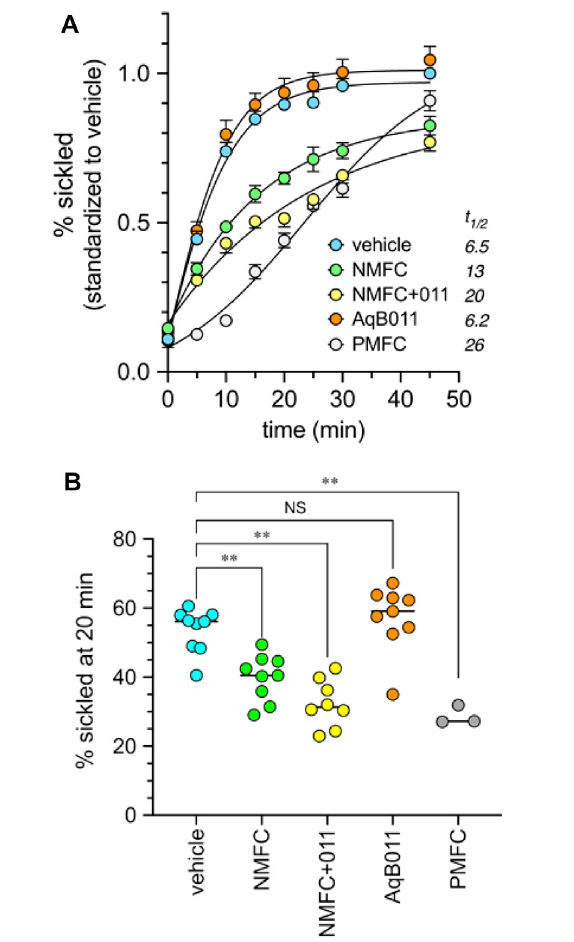
FIGURE 8 | Combined application of agents that inhibit AQP1 ion channels (AqB011) and that modify hemoglobin (5-NMFC) reduce the rate of sicklingofhumanSCDcellsinhypoxicconditions,approachingtheprotection seenwith5-PMFCalone. (A) Dataforpercentsicklingwerestandardized to the mean maximum sickling (at 45 min) measured in the vehicle controls in the same experimental group; data within treatments were averaged for all experiments to determine mean and SEM values, and plotted as a function of time in full nitrogen starting at time zero. Estimated t 1/2 values ( fi gure legend) show the times needed in minutes to reach 50% of the net maximal sickling level, set as the level observed for vehicle-treated cells at 45 min. Data were compiledfrom threeseparateexperiments with2to3replicatesampleseach. n values are as shown in the dot plot below. (B) Dot plot summary of raw data for the percentages of sickled cells at 20 min hypoxia compiled from three independent experiments. Concentrations ofagentsusedwere2.5 mM for5- NMFC and 5-PMFC, 80 µM for AqB011, and equivalent DMSO for the vehicle control. Signi fi cant differences were determined by ordinary one-way ANOVA with Š idác ’ s multiple comparisons test. ** p < 0.01; NS is not signi fi